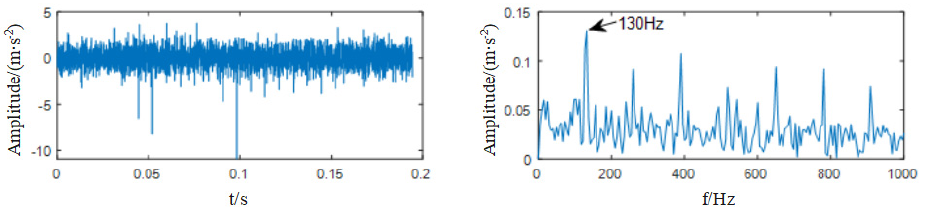
Figure 8. Time-domain and envelope maps after SSA-CYCBD-enhancement of inner ring fault features.